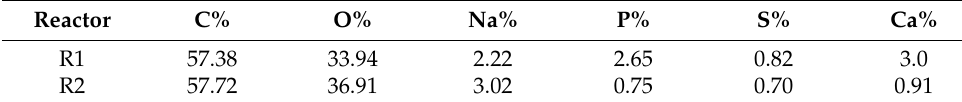
Table 3. Elemental analysis of aerobic granular sludge by EDS.